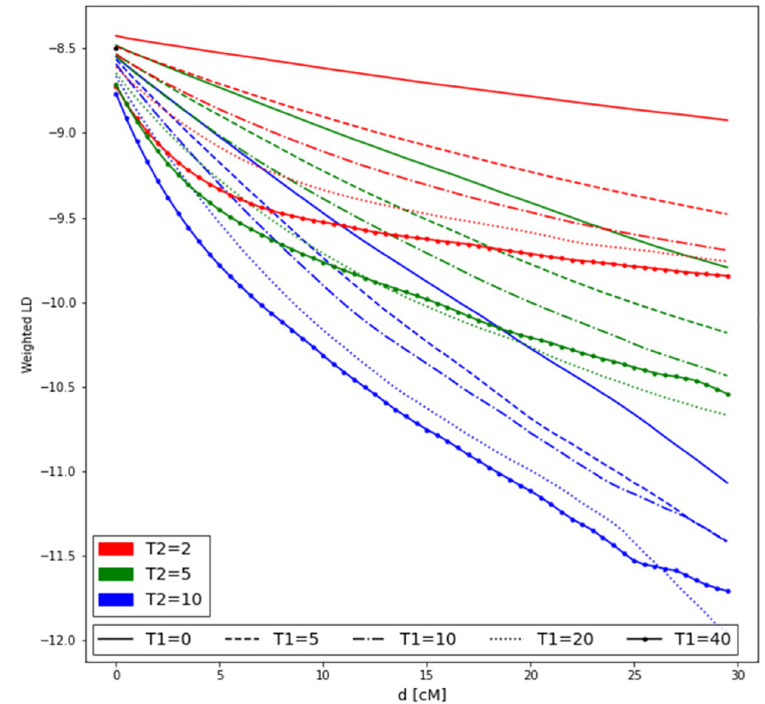
Fig 4. Two-locus weighted LD with two admixture events and varying pulse times. Corresponding ALDER curves for two-pulse admixture with varying pulse times. Morgans on x -axis and log ALDER scores on y -axis. Red lines are T 2 = 2, Green lines T 2 = 5, and blue lines are T 2 =